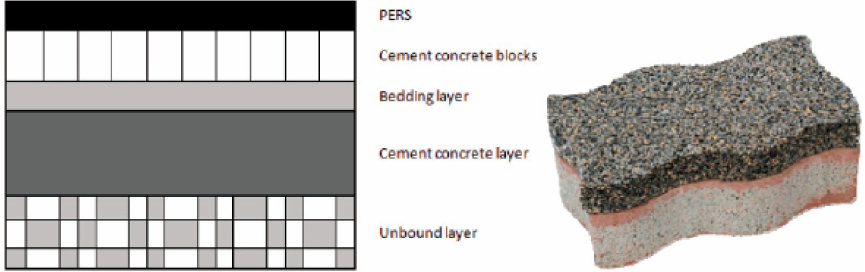
Figure 9. Porous elastic road surface samples [59].